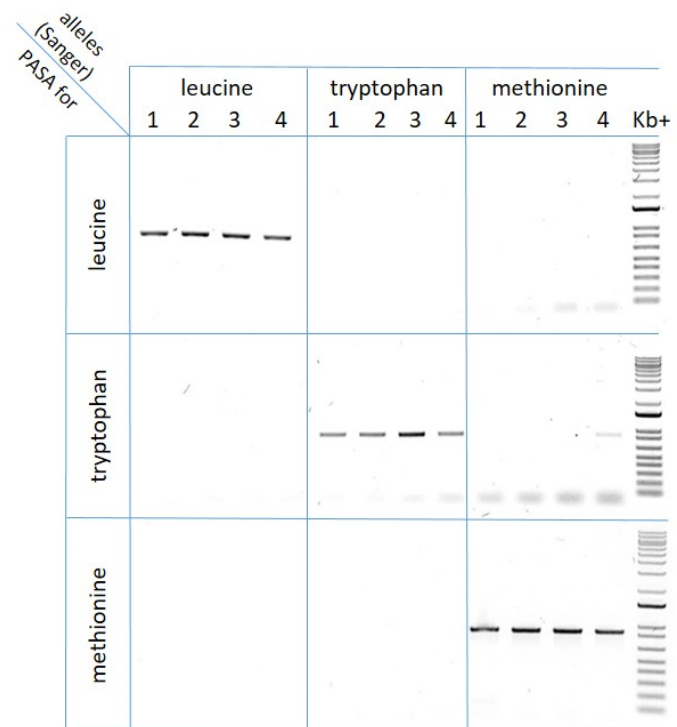
Figure 2. Setup of allele-specific PCR assay (PASA) using three PCR mixes specific to leucine (upper), tryptophan (middle) and methionine (bottom) on three A. hybridus reference seed samples: in